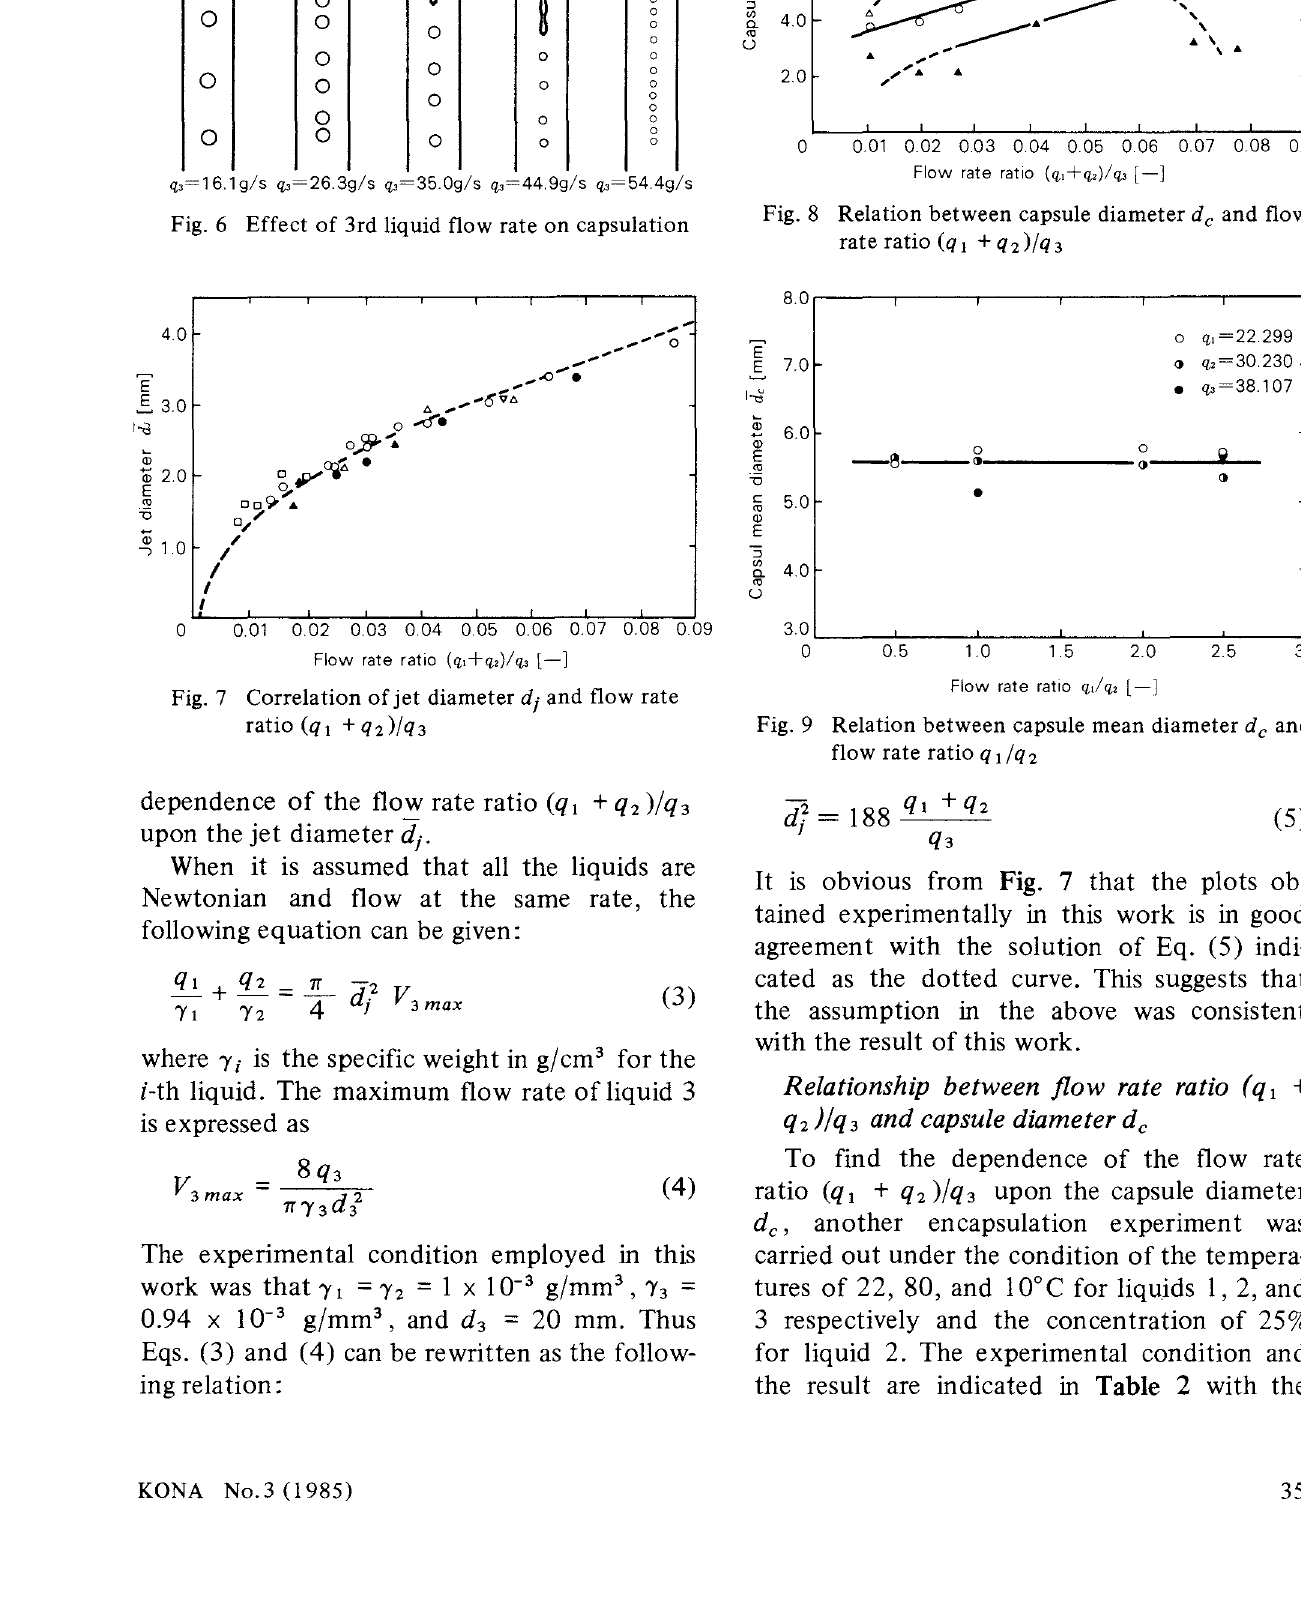
Fig. 6 Effect of 3rd liquid flow rate on capsulation